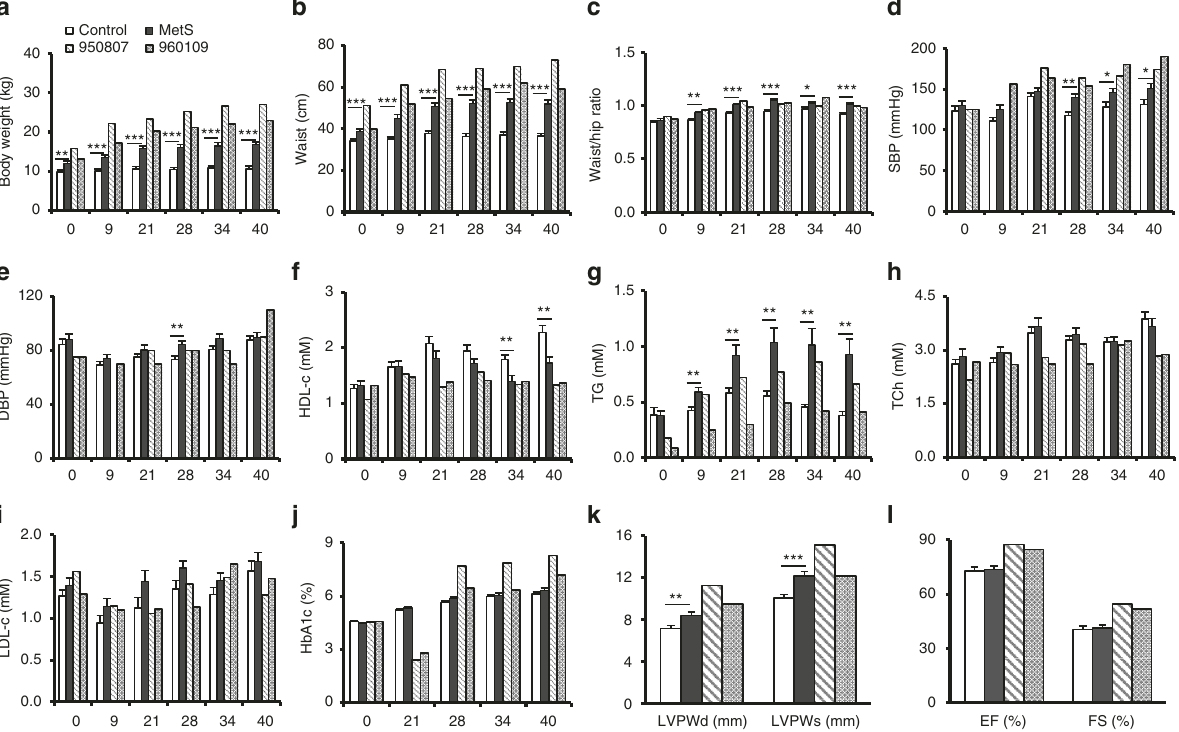
Fig. 2 Metabolic and anthropometric parameters of control, MetS, and hyperinsulinemic monkeys. a Body weights. b Waist circumferences. c Waist/hip ratios. d SBP, systolic blood pressures. e DBP, diastolic blood pressures. f HDL-c, high-density lipoprotein cholesterol. g TG, triglyceride. h TCh, total cholesterol. i LDL-c, low-density lipoprotein cholesterol. j HbA1c, hemoglobin A1c. k LVPWd (left ventricular posterior wall thickness at end-diastole) and LVPWs (left ventricular posterior wall thickness at end-systole) at 40 months of follow-up studies. l EF (ejection fraction) and FS (fraction shortening) at 40 months of follow-up studies. * p < 0.05, ** p < 0.01, *** p < 0.001, control vs MetS (Control, n = 16; MetS, n = 17). All data are represented as mean ± SEM, the signi fi cant difference between groups was assessed by the Student ’ s t